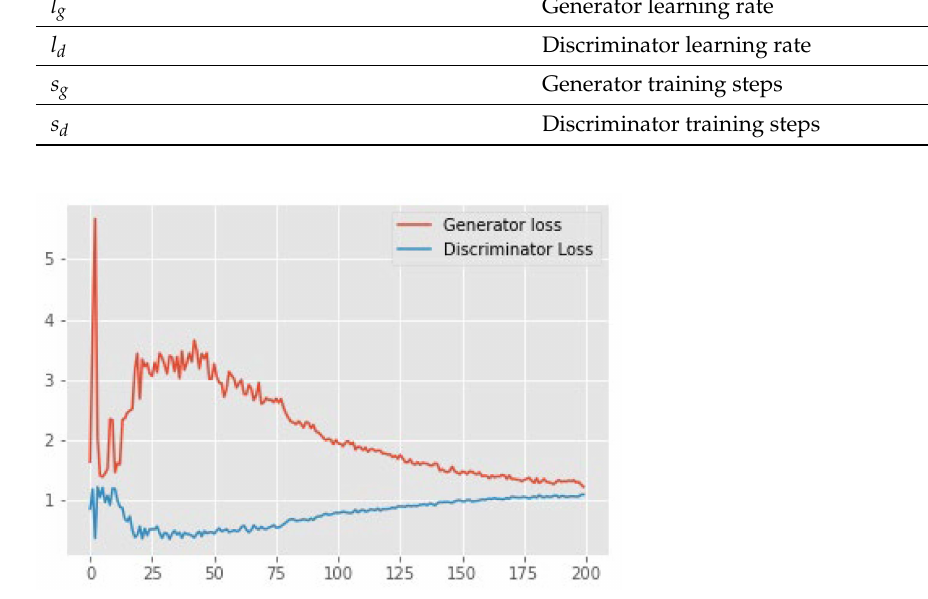
Figure 5. Training